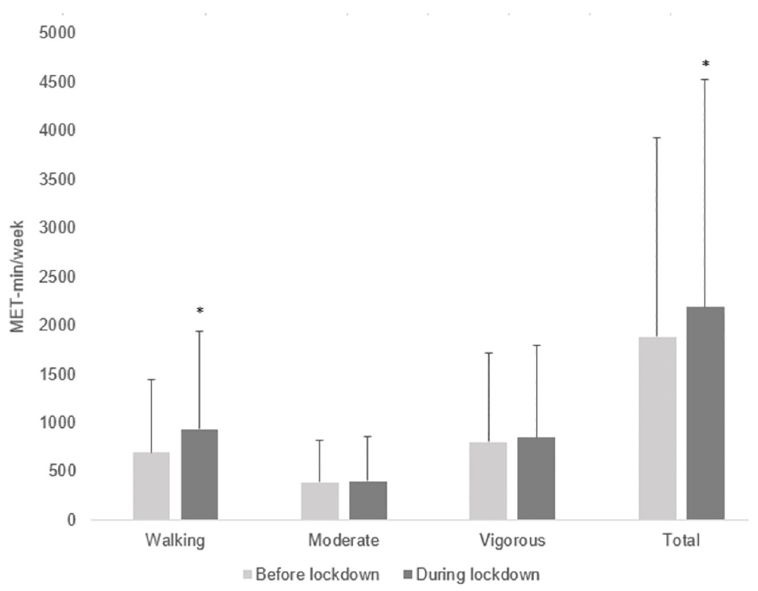
Fig 1. Changes in physical activity before and during lockdown (mean and 95% confidence intervals). � significant difference before compared to during lockdown.